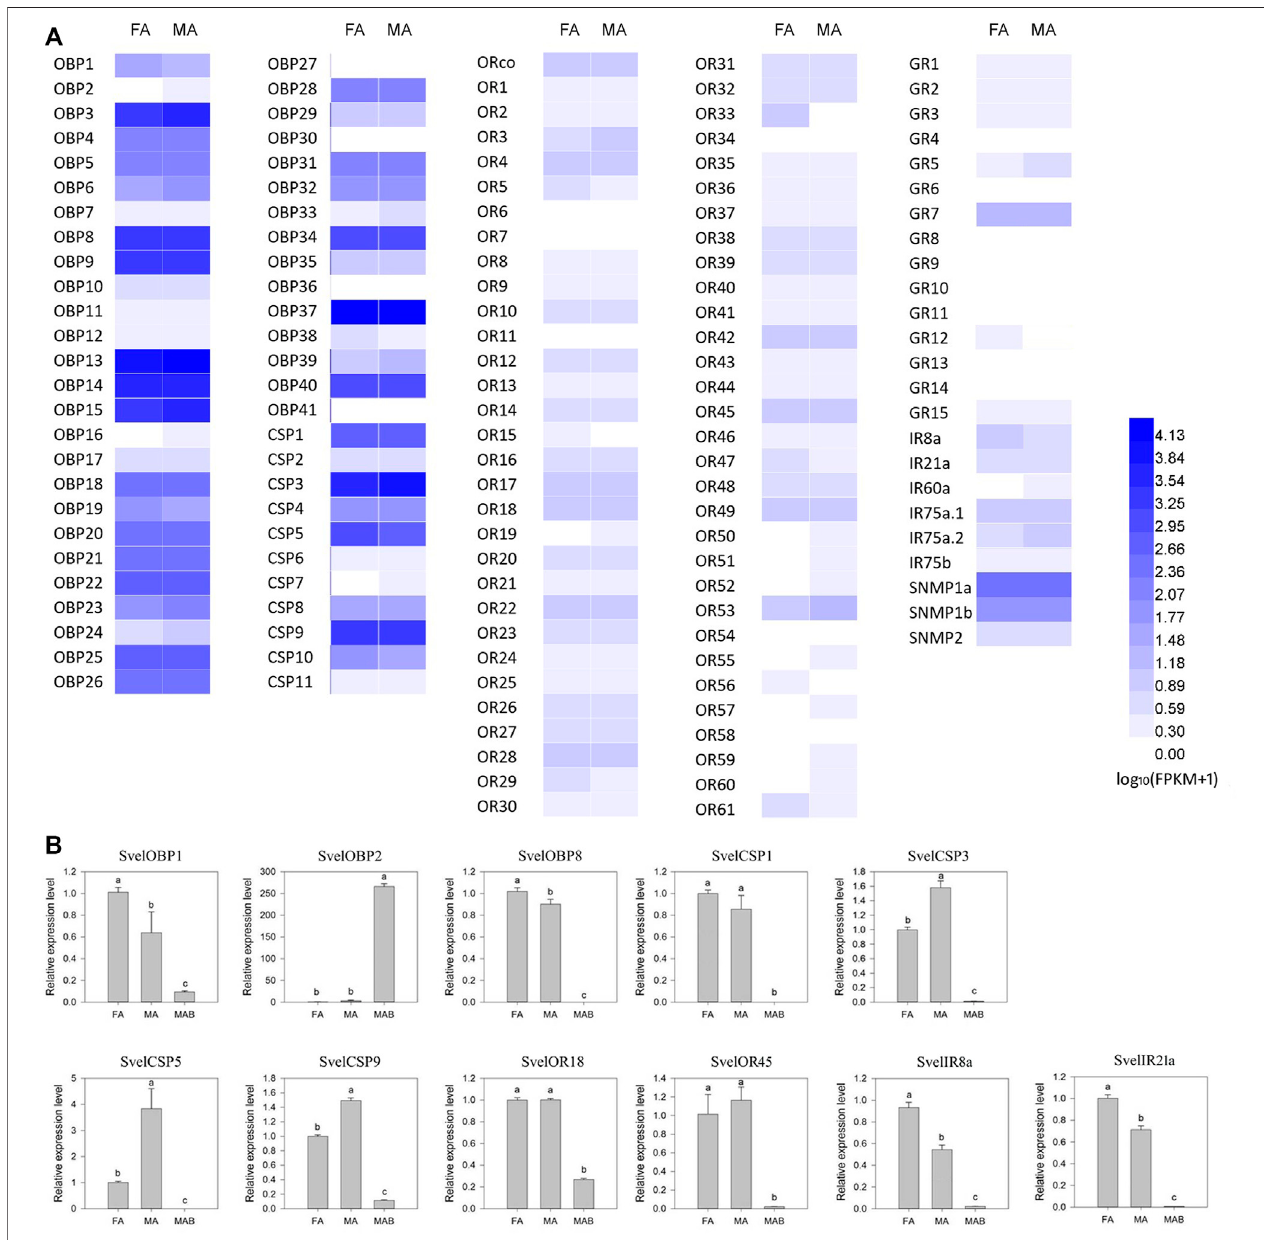
FIGURE 7 | Expression pro fi les of candidate chemosensory genes in Sympiezomias velatus based on average RPKM values (A) and determined by RT-qPCR analysis (B) . FA, female antennae; MA, male antennae; MAB, male abdomen. The RT-qPCR data for each tissue were fi rst normalized against RPS20 , and female antennae were selected as the calibrator. The relative expression levels are means ± SE ( n = 3) and were statistically analyzed by one-way ANOVA followed by Tukey ’ s test. Different lowercase letters indicate signi fi cant differences at the 0.05 level.